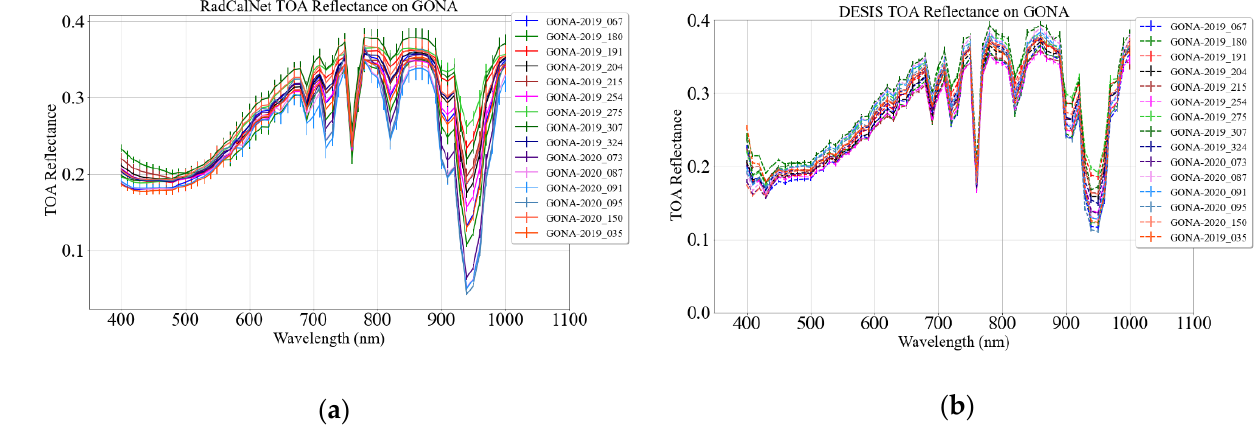
Figure 10. GONA TOA reflectance: RadCalNet ( a ) and DESIS ( b ). Figure 10a shows GONA TOA reflectance using RadCalNet with 1-sigma standard